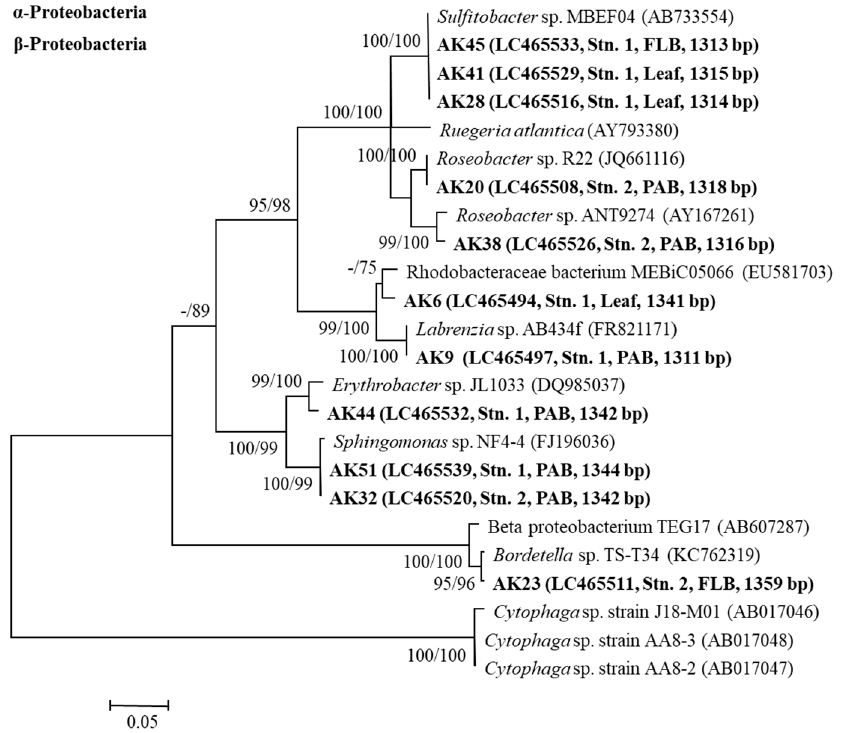
Figure 14. Phylogenetic tree for α - and β -proteobacteria isolates based on the 16S rRNA gene sequences (~1300 bp). The tree was constructed using the maximum likelihood method (ML). Numbers at nodes indicate bootstrap values (neighbor joining method (NJ)/ML). Numbers after the strain name are the accession numbers. PAB: particle-associated bacteria, FLB: free-living bacteria, Leaf: isolated from a leaf of the seagrass Zostera marina . The bacterial name AK is the strain iso- lated in this study. The outgroup algicidal bacteria are reported by previous study [32].